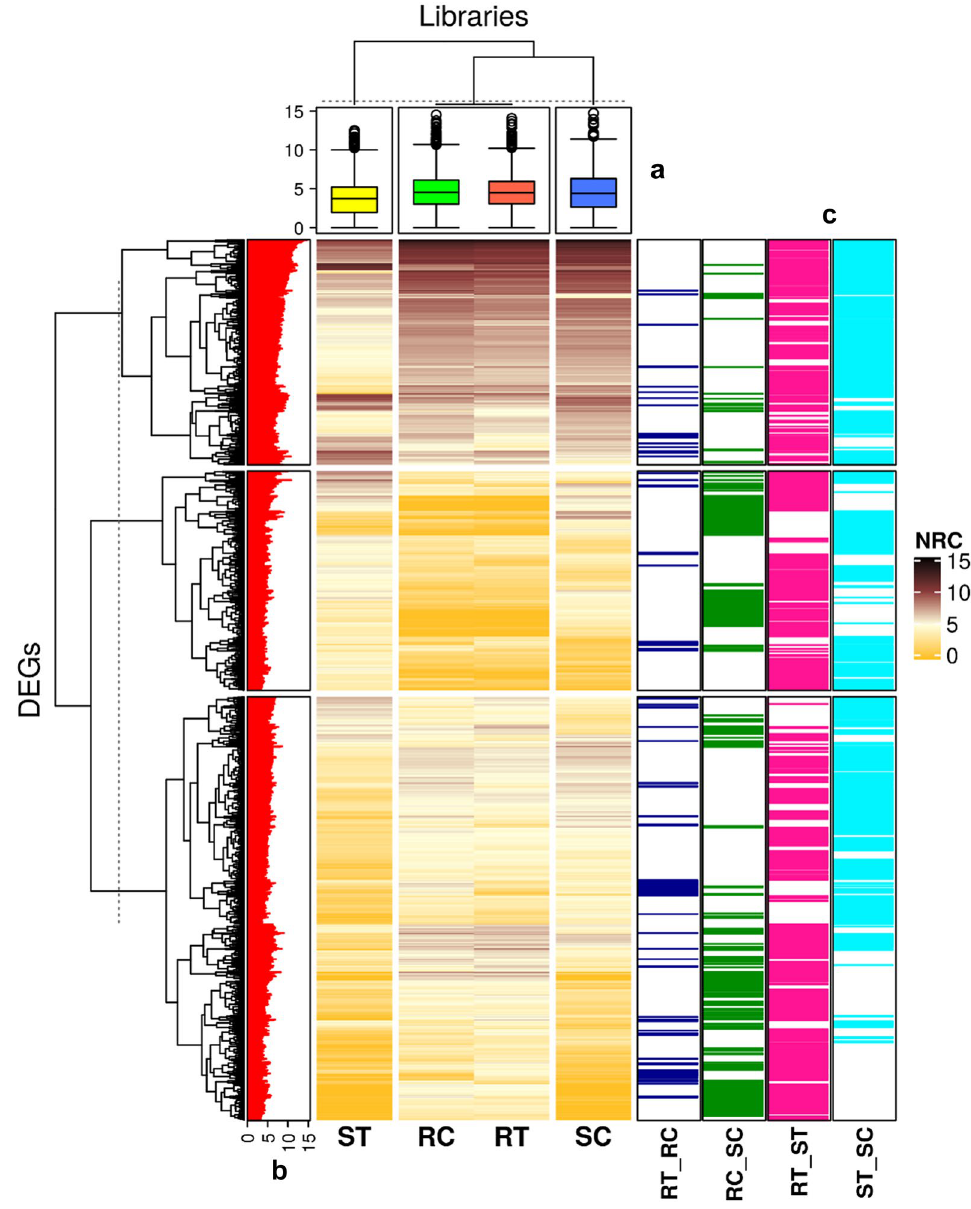
Figure 5. Heat map for log 2 gene expression profile in the resistant and susceptible genotypes combining with box plot ( a ) and bar plots ( b , c ). The rows of main plot represent the differentially expressed genes (DEGs) and columns denote samples. RC (resistant control), RT (resistant treatment, at 24 hpi), SC (susceptible control), and ST (susceptible treatment, at 24 hpi). NRC denotes normalized read count by TMM method. ( a ) The box plot displays distribution of log 2 gene expression profile. ( b ) The bar plot shows maximum expression of each gene in samples. ( c ) The bar plots denote the frequency of DEGs in each comparison (RT_RC: 120 DEGs, RC_SC: 390 DEGs, RT_ST: 984 DEGs and ST_SC: 905 DEGs). The figure was created using the ‘ComplexHeatmap’ R/ Bioconductor package 21